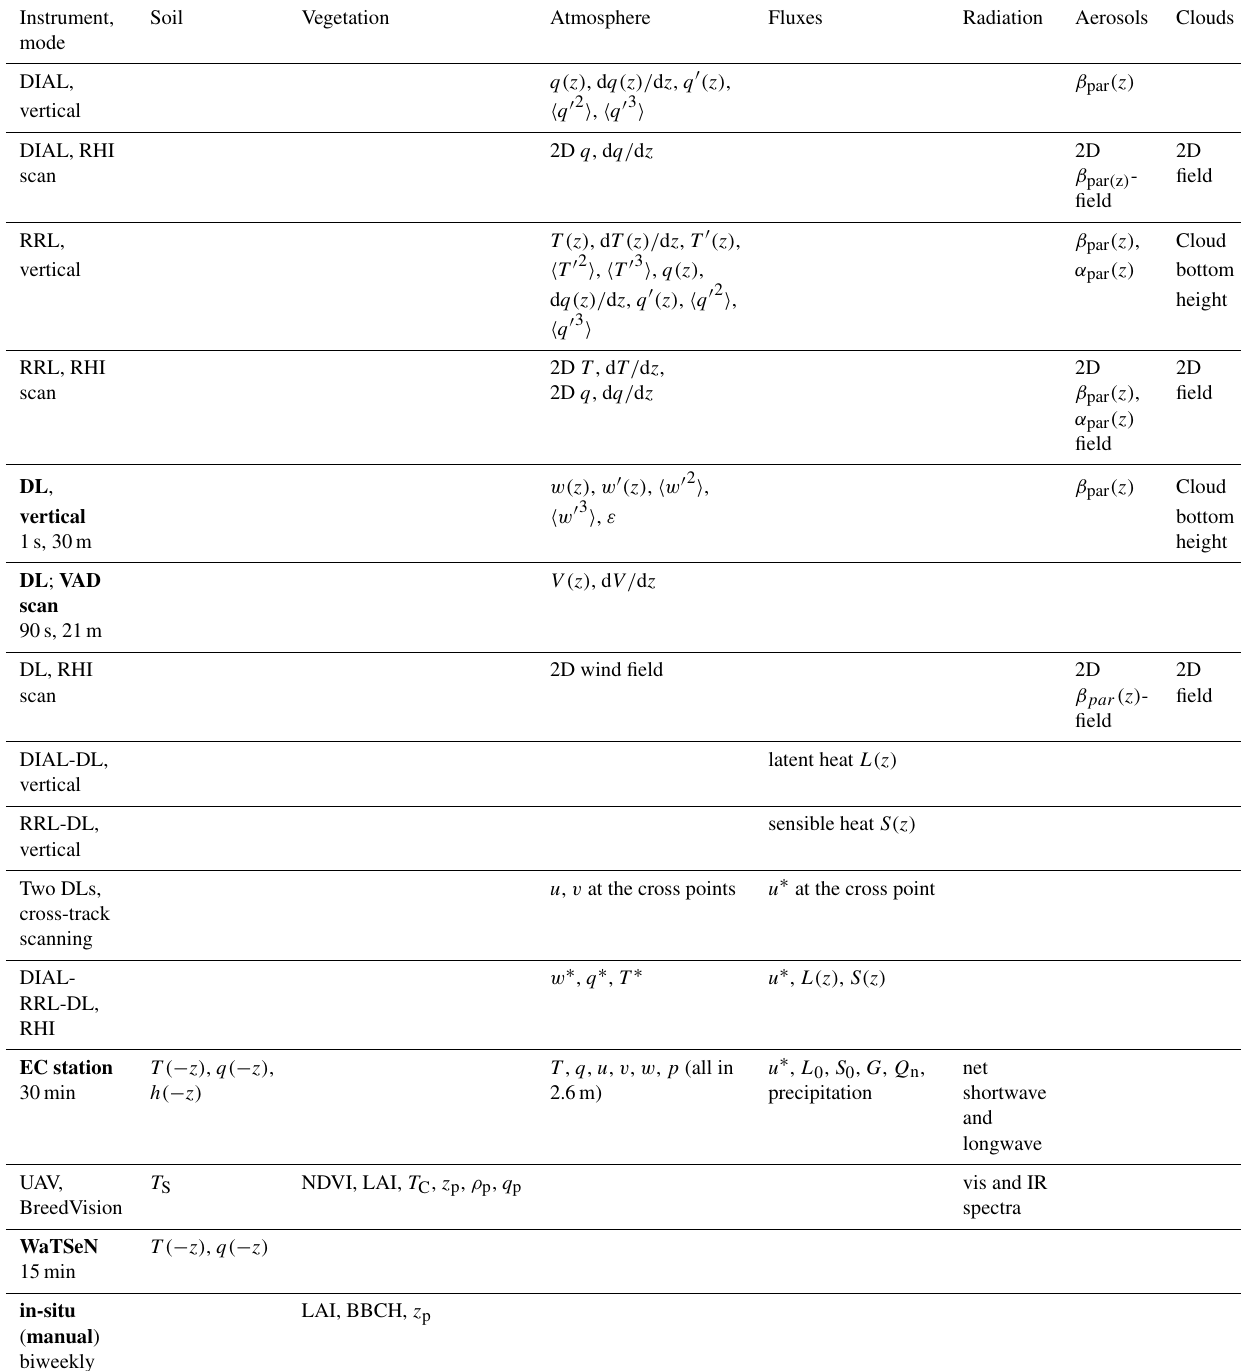
Table 1. Measured variables with the LAFO sensor synergy. Instruments in bold are operated continuously. For these instruments we also give the temporal and spatial resolutions; otherwise we refer to the instrument descriptions in Sect. 3 and the corresponding references. RHI scan refers to the range height indicator scanning operation to measure vertical cross